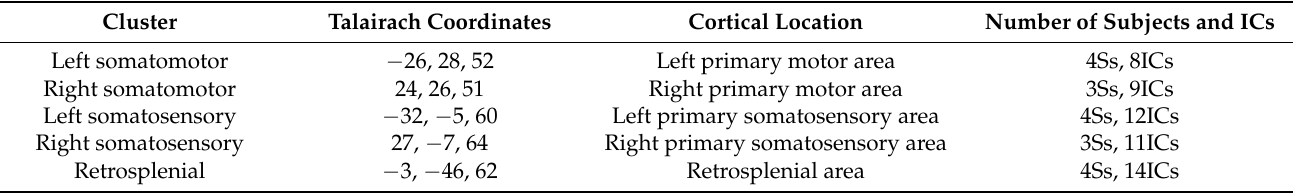
Table 2. IC clusters and cluster centroid